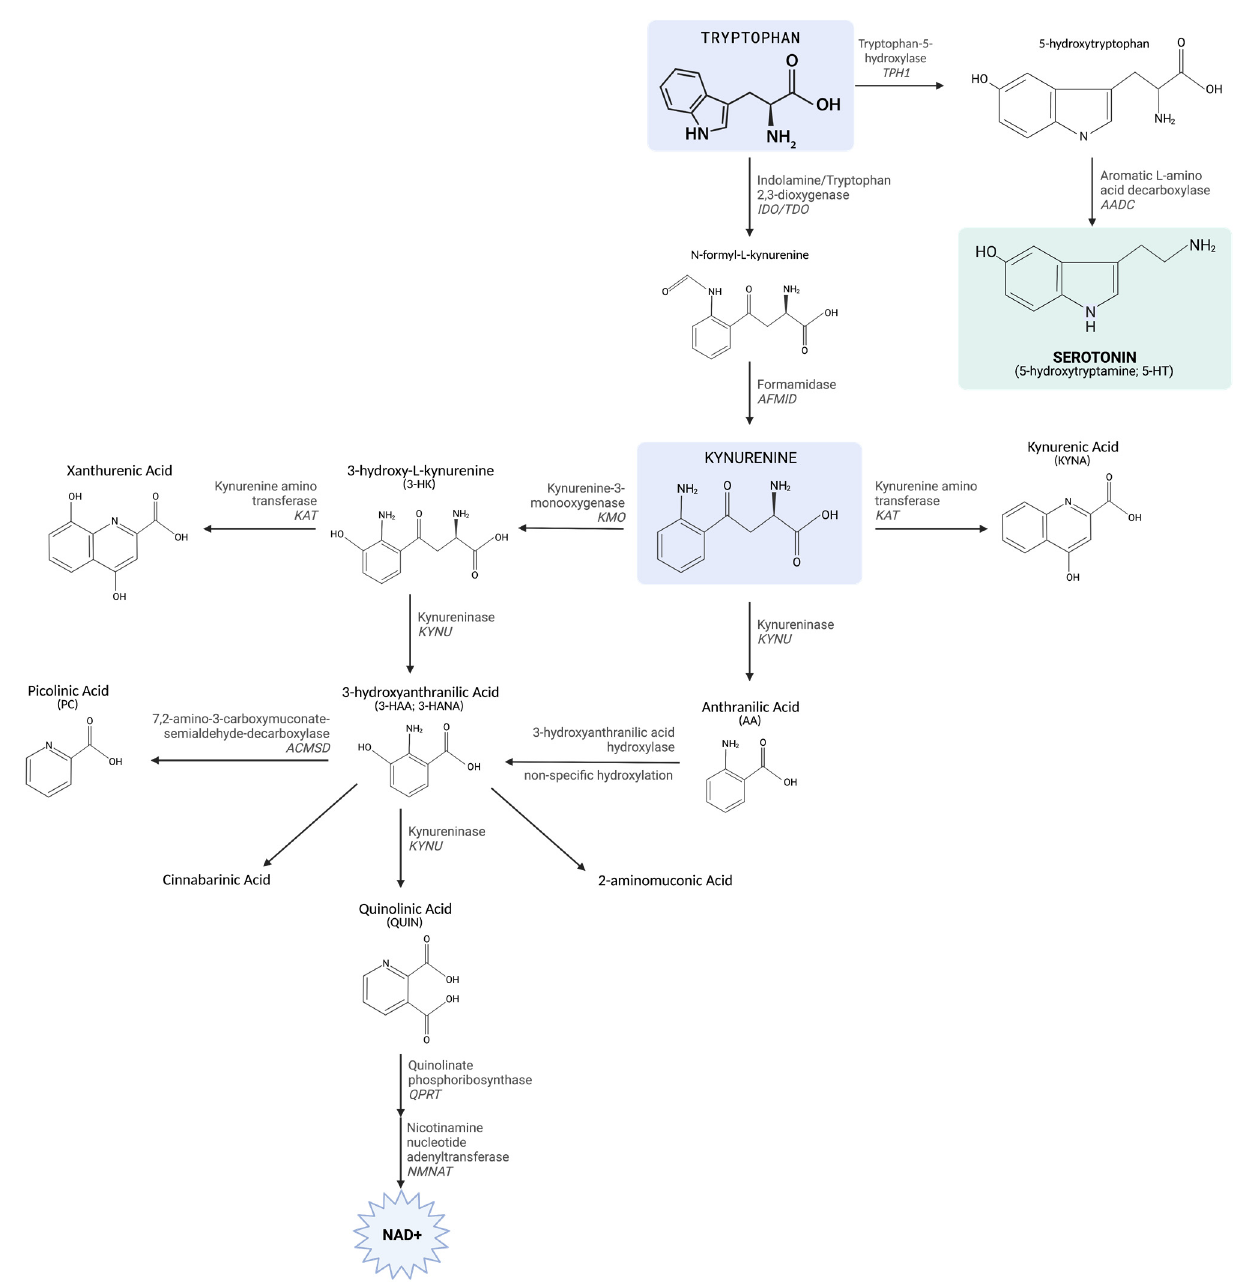
Figure 1. Key enzymes regulating TRP metabolism. The pathway depicting key regulators and targets that play a role on the TRP metabolism with a connection to KYN and 5-HT. Figure created on biorender.com.